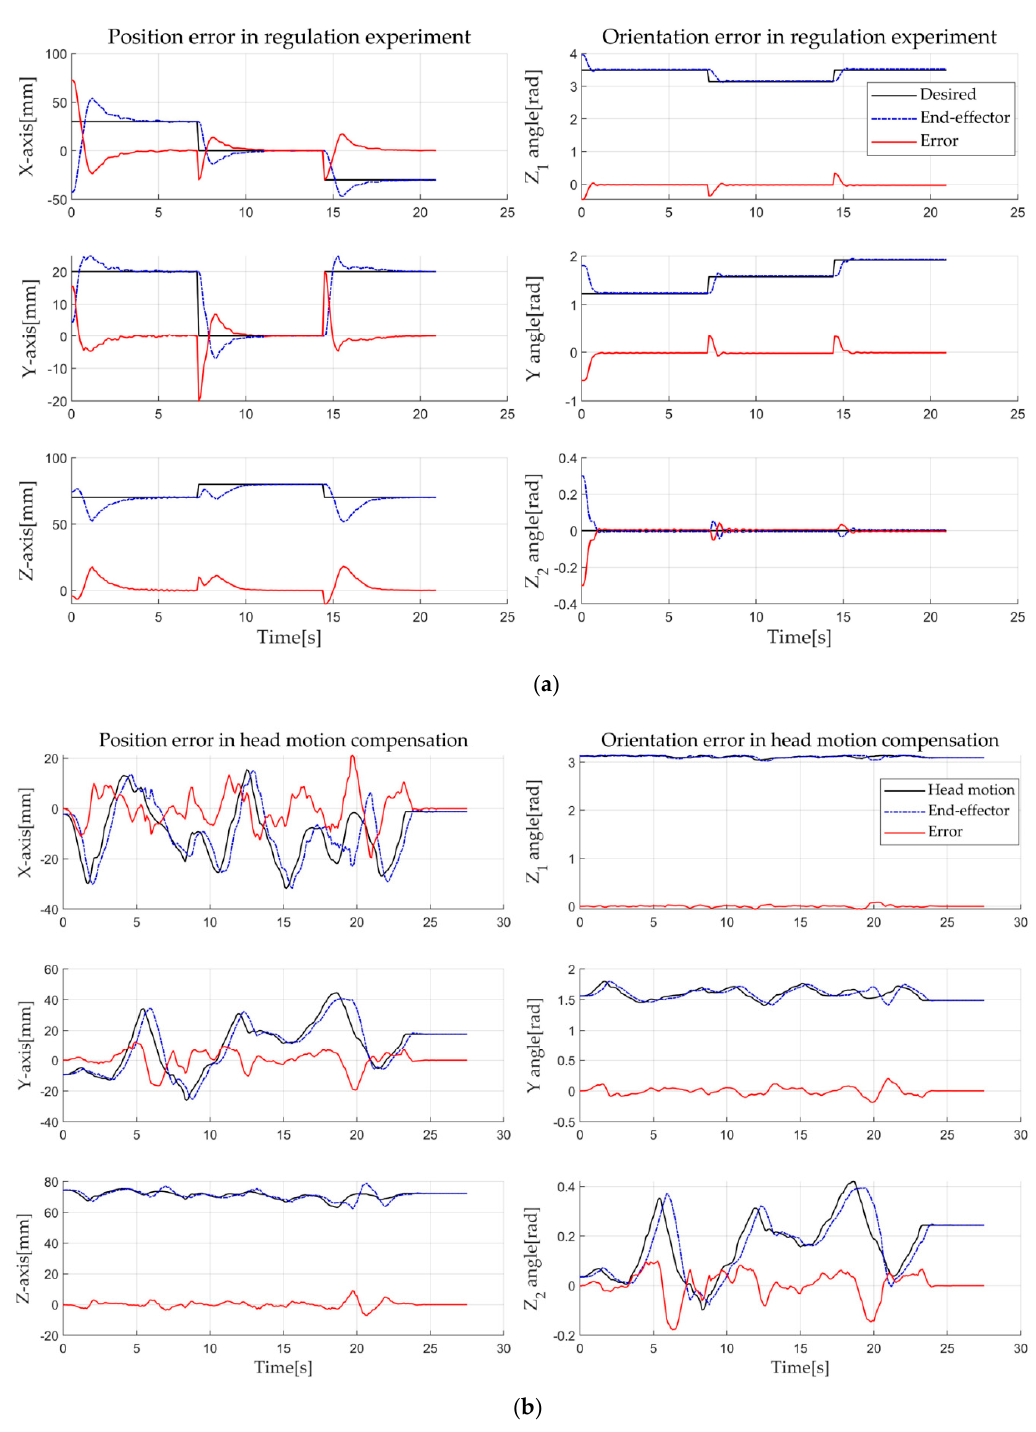
Figure 9. Regulation and motion compensation experiment of robotic system; ( a ) is the result when three different static target postures were given, and ( b ) is the result for head motion compensation.